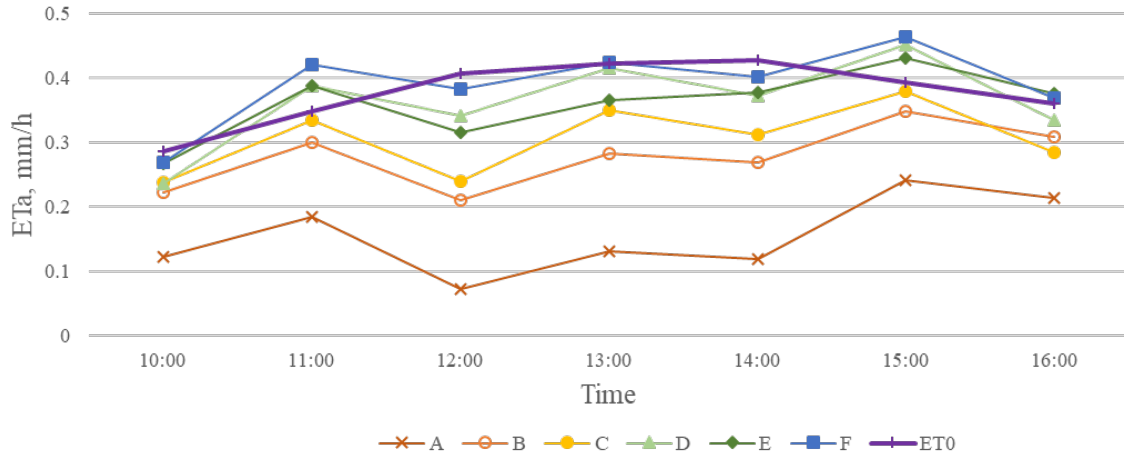
Figure 10. ET aNDVI (mm h − 1 ) derived from WDI NDVI diurnal variation on 23 April 2020. The treatment names A–F refer to treatments from the lowest to the highest irrigation amounts, respec- tively. Reference evapotranspiration ET 0 (mm h − 1 ) was calculated using the Penman–Monteith equation